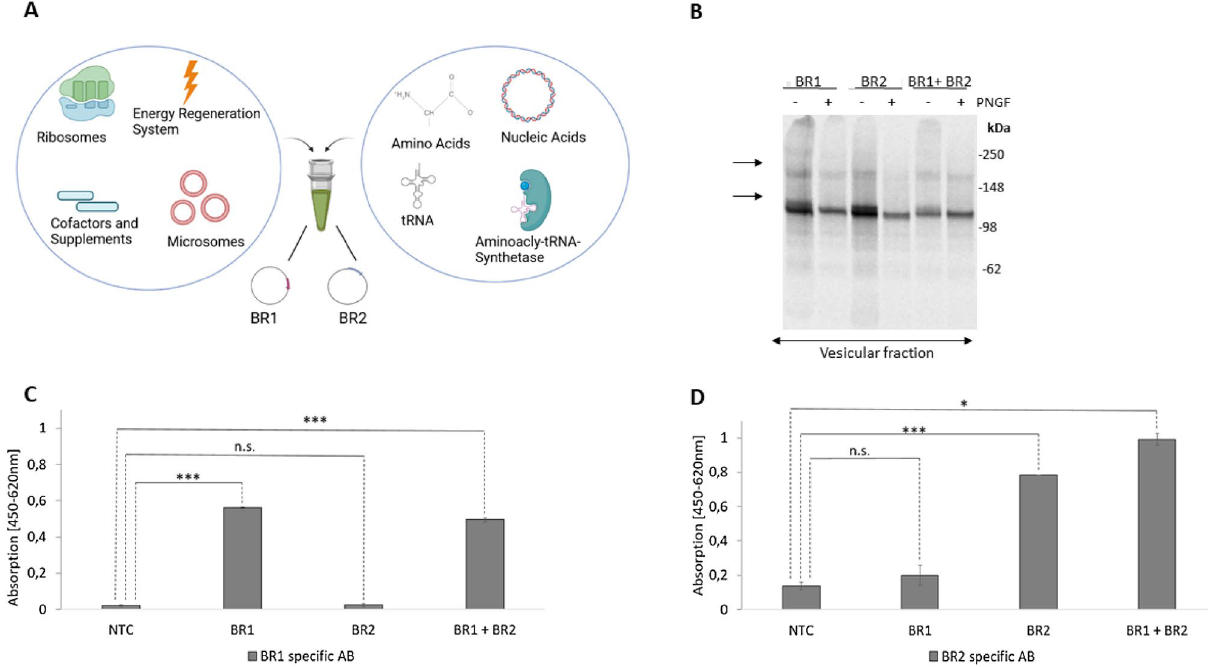
Figure 1. Cell-free protein synthesis of individually and coexpressed GABA B forming subunits: ( A ) Schematic Illustration of cell-free synthesis of the GPCR, GABA B , in a eukaryotic cell-free system ( Sf 21). ( B ) Autoradiograph showing 14 C-labeled individual cell-free synthesis and equimolar coexpression of subunits 1 (BR1) and 2 (BR2). Samples were PNGase F (PNGF) treated (plus and minus) and arrows indicate the corresponding bands (BR1: 109.7 kDa, BR2: 107.2 kDa). ( C ) Detection of cell-free synthesized proteins with rabbit primary antibody targeting BR1 subunit by an equimolar enzyme-linked immunosorbent assay (ELISA). Individual and coexpression of BR1 and BR2 were applied (n = 3). ( D ) Detection of cell-free synthesized proteins using primary mouse antibodies targeting BR2 by an equimolar ELISA (n = 3). Individual and coexpression of BR1 and BR2 were applied (n = 3). A p-value of < 0.05 was considered statistically significant and indicated by *, while a p-value < 0.001 is indicated by